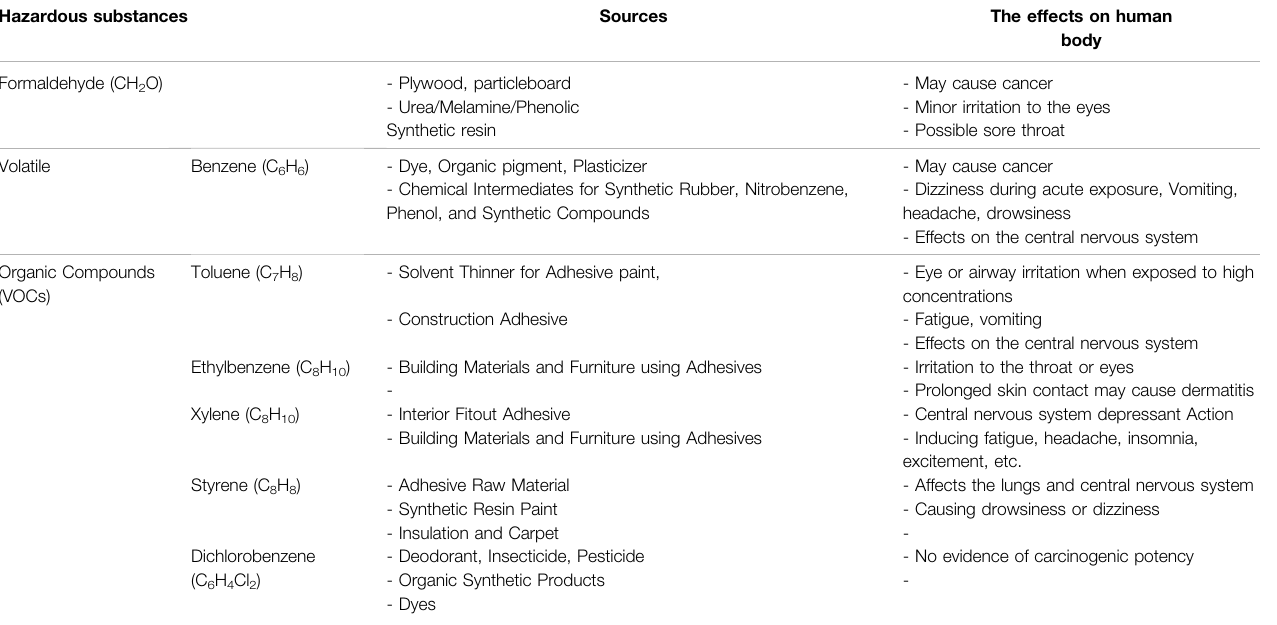
TABLE 2 | The effects of hazardous substances on the human body (source: Jung,